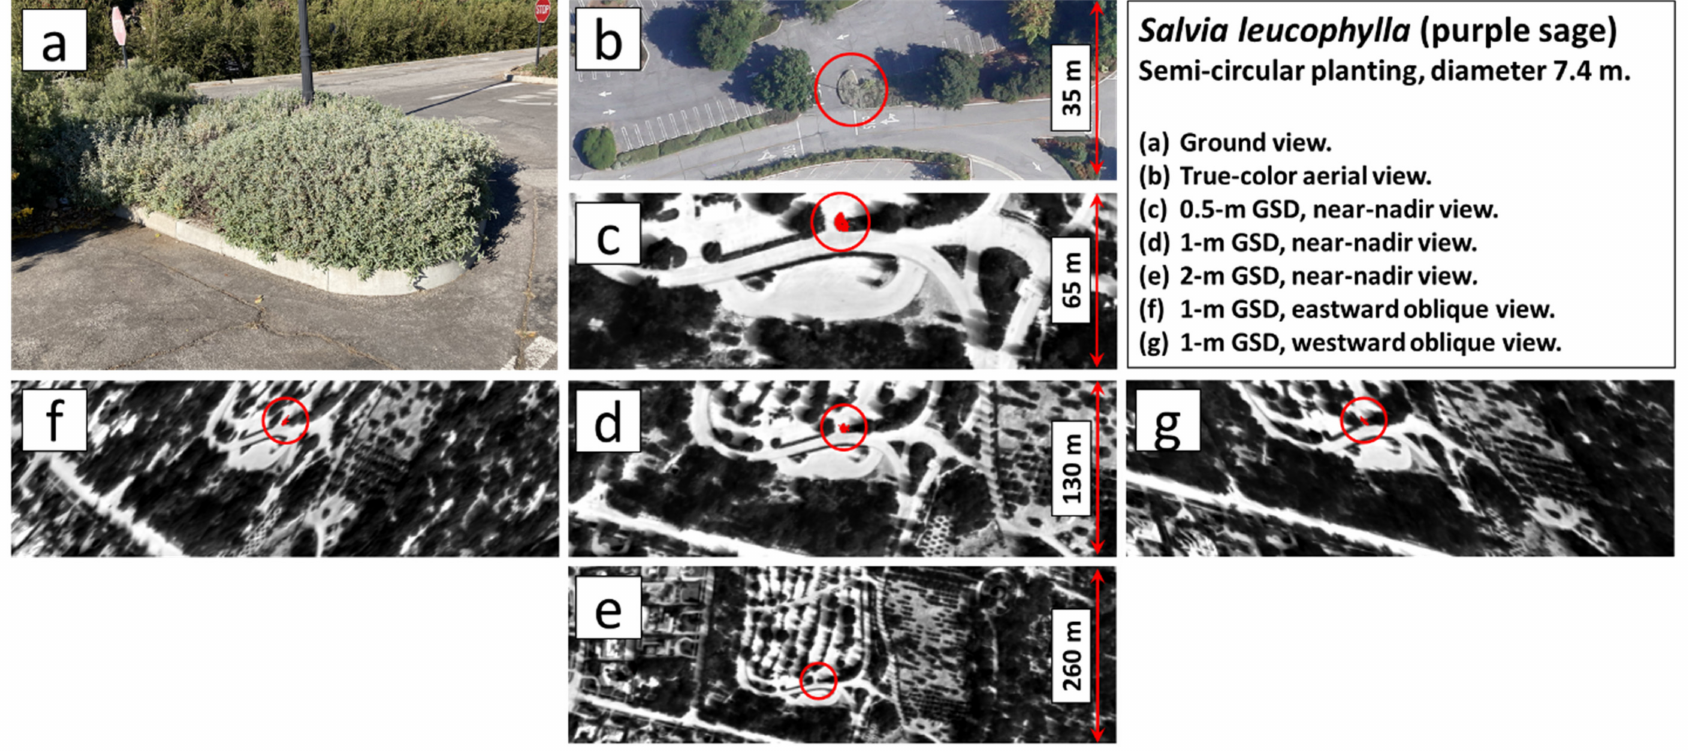
Figure 4. Salvia leucophylla ID as a function of GSD and observation angle: ( a ) ground view of target planting, ( b ) true-color aerial image, ( c ) thermal scene image at 0.5-m GSD with target ROI overlay (red), ( d ) thermal scene image at 1-m GSD with target ROI overlay (red), ( e ) thermal scene image at 2-m GSD with target location circled (no ROI was generated), ( f ) eastward-looking oblique thermal scene image at 1-m GSD with target ROI overlay (red), ( g ) westward-looking oblique thermal scene image at 1-m GSD with target ROI overlay